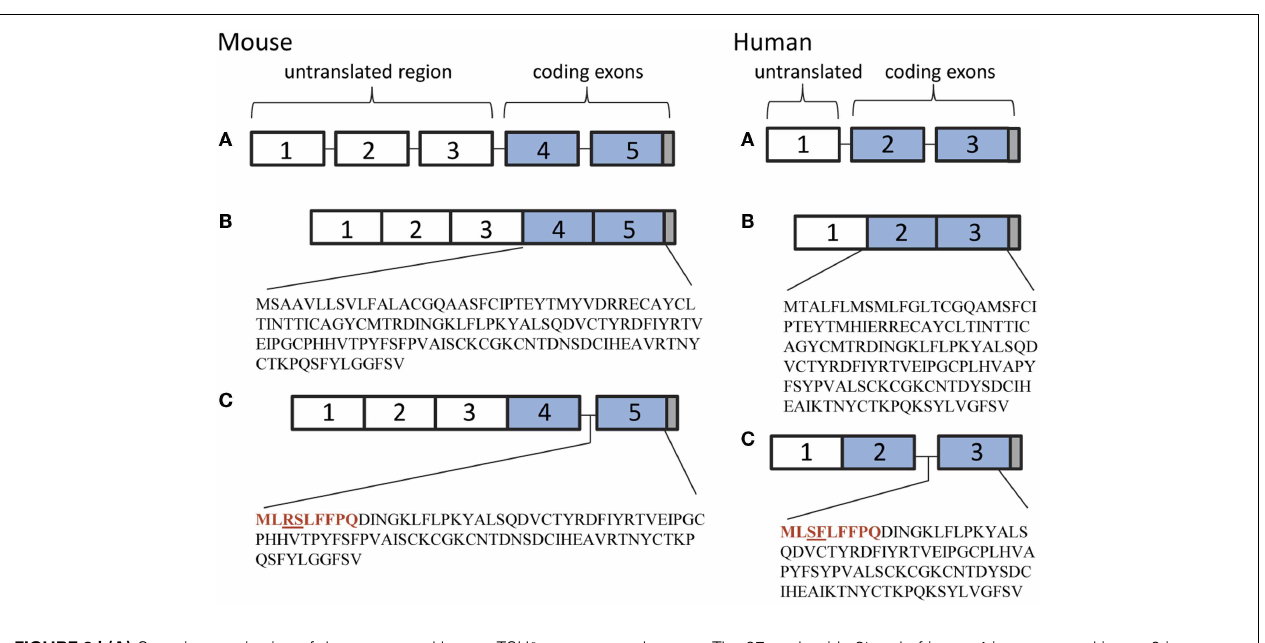
FIGURE 2 | (A) Genetic organization of the mouse and humanTSH β gene. (B) The nativeTSH β polypeptide in mice and humans is coded for by exons 4 and 5, and exons 2 and 3, respectively (blue boxes). (C) The TSH β v polypeptide is coded for by exon 5 in mice and exon 3 in